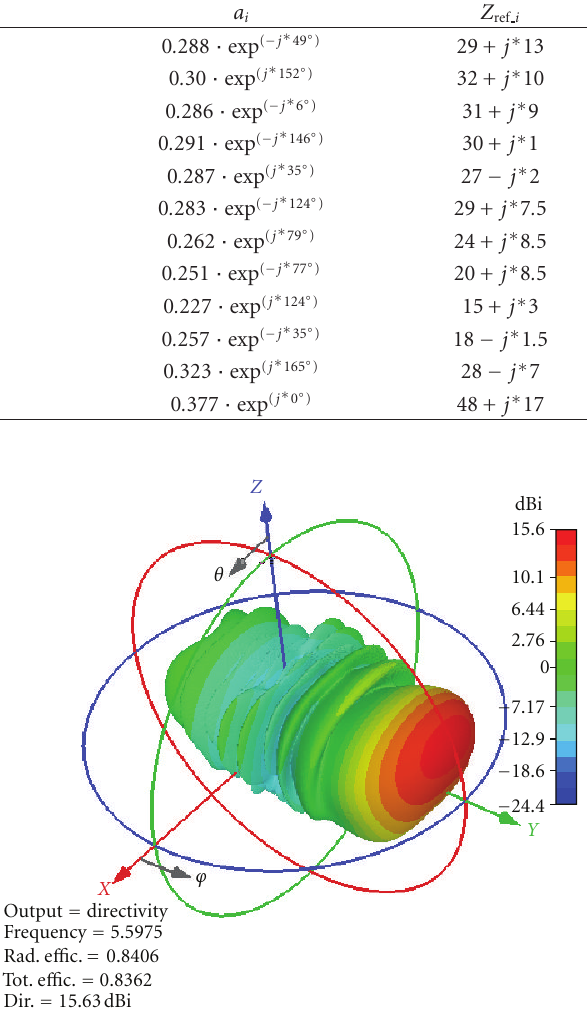
Figure 9: Simulated radiation pattern in 3D (directivity) at f = 5 .